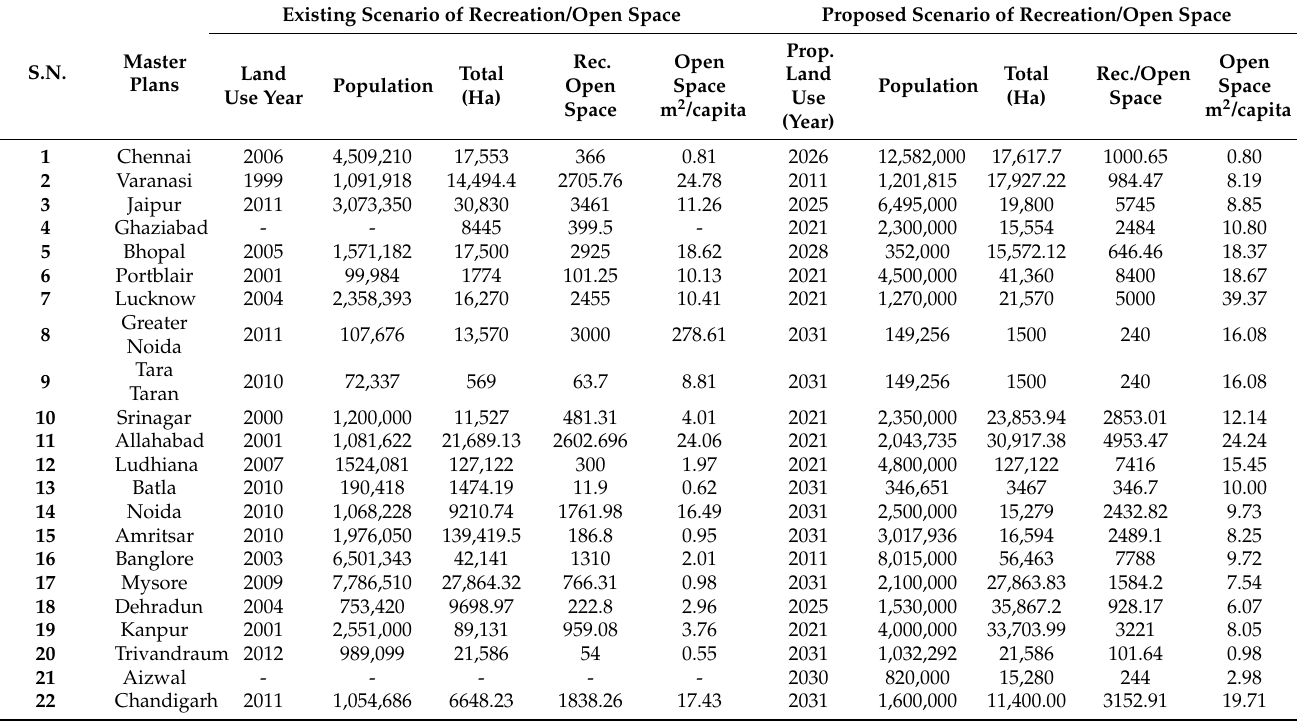
Table A1. Area Under Park and Open Spaces in Indian Cities.